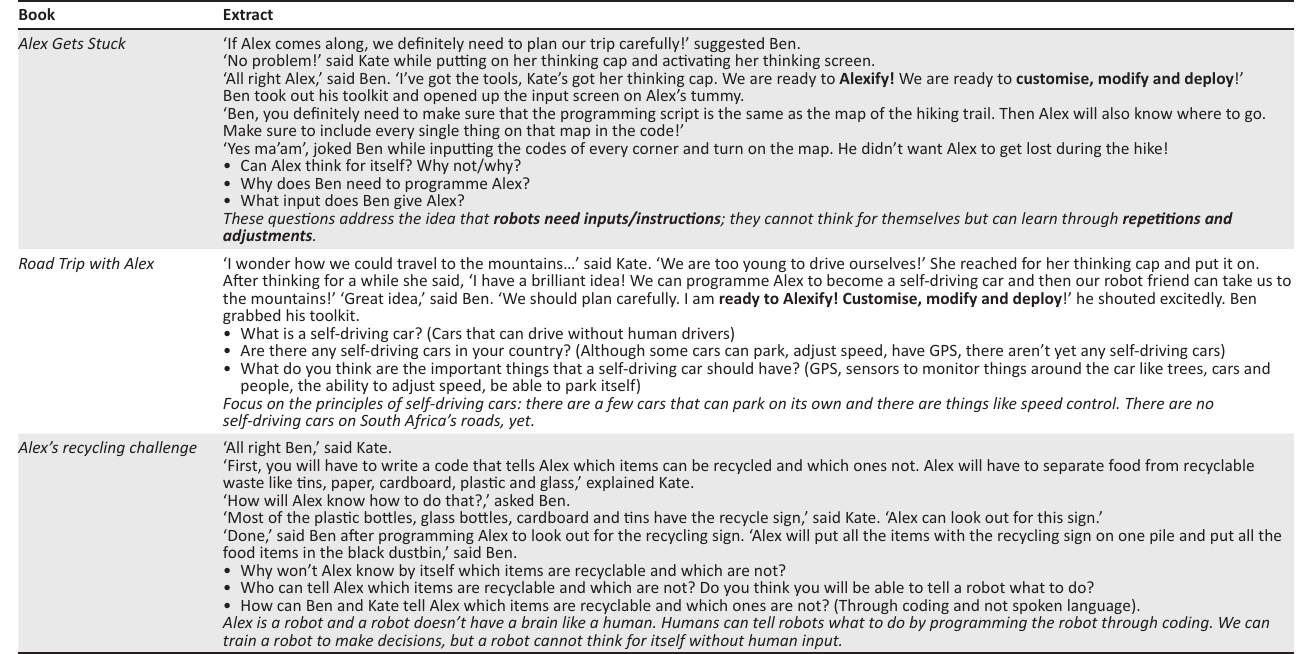
TABLE 1: Extracts from the dialogue reading programme.